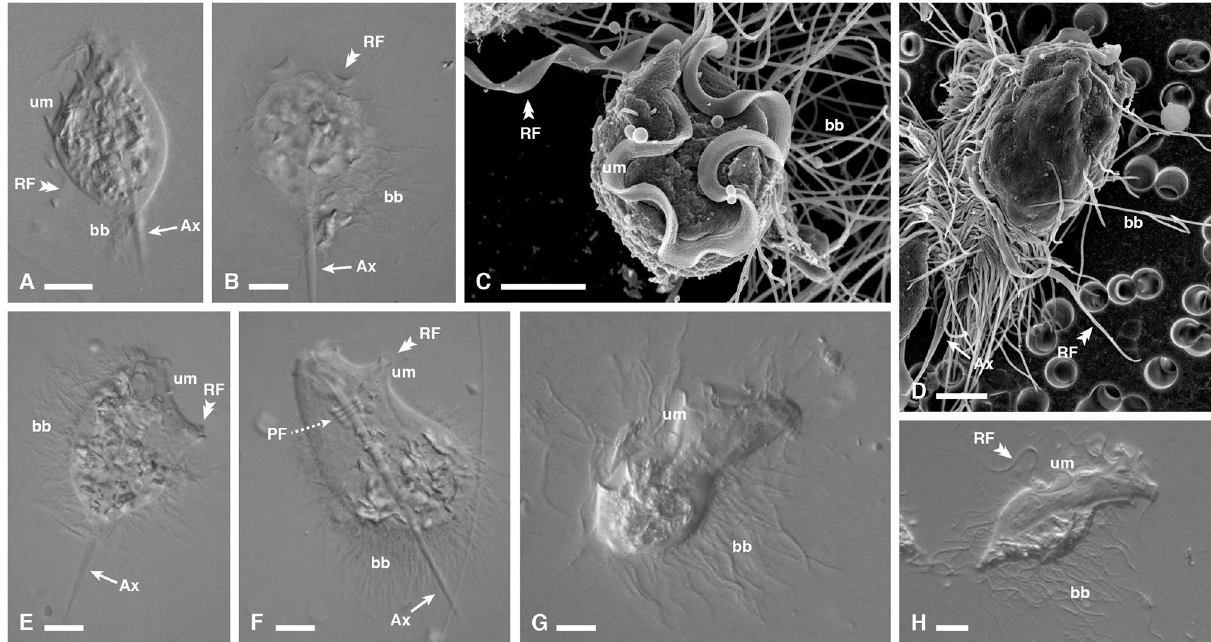
Figure 2. Light and electron micrographs of new Macrotrichomonas specimens. ( A , B ) Differential interference contrast (DIC) and ( C , D ) SEM images of Macrotrichomonas ashaninka from Comatermes perfectus showing the overall body shape, with the recurrent flagellum forming an undulating membrane where it adheres to the cell. Also visible are the axostyle and tufts of bacteria adhered to the cell surface. ( E , F ) DIC images of Macrotrichomonas secoya from Calcaritermes temnocephalus showing the overall body shape, with the recurrent flagellum forming an undulating membrane where it adheres to the cell. Also visible are bacterial tufts attached to the cell surface, and parabasal fibers coiled around the axostyle. ( G , H ) DIC images of Macrotrichomonas yanesha from Calcaritermes rioensis showing the overall body shape, with the recurrent flagellum forming an undulating membrane where it adheres to the cell. Also visible are tufts of long bacteria on the cell surface. RF recurrent flagellum, um undulating membrane, Ax axostyle, bb bacteria, PF parabasal fibers.